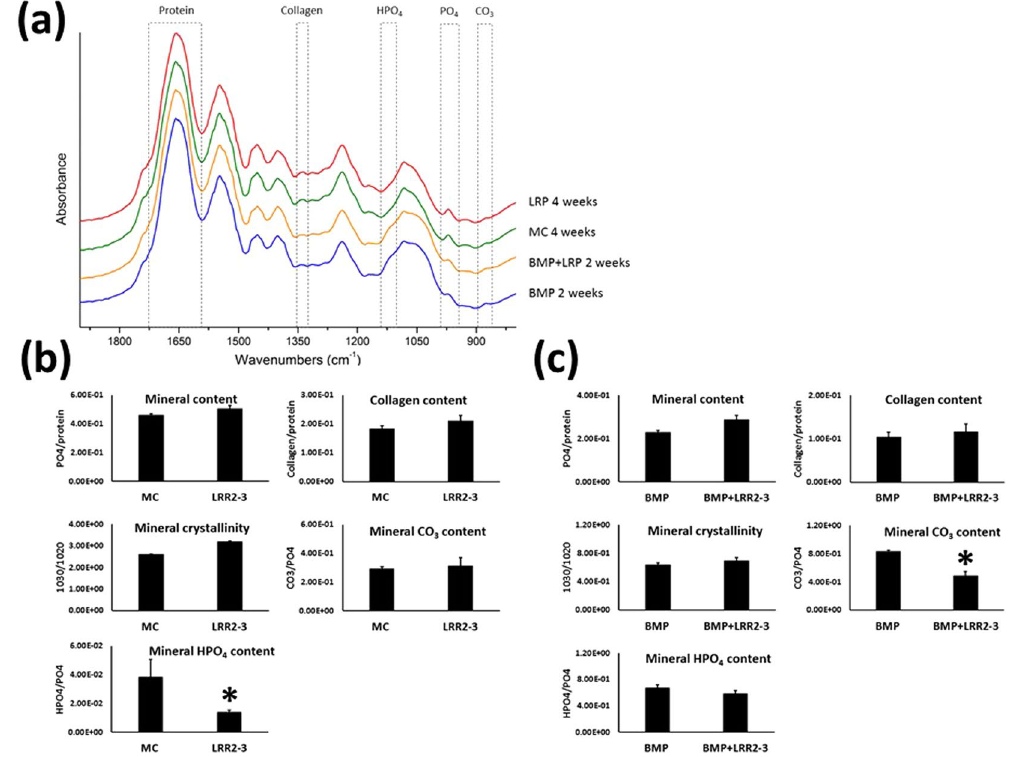
Figure 6. Fourier transform infrared (FTIR) spectroscopy analysis. ( a ) FTIR spectra of the cell culture samples, highlighting the regions of interest: amide I absorbance band for protein, collagen absorbance, the ν 1 PO 4 absorbance band reflecting mineral, the CO 3 absorbance band reflecting carbonate incorporated into the mineral, and the HPO 4 band reflecting acid phosphate incorporated into mineral. Second derivative spectra were used to narrow the broad absorbance peaks, and the peak intensities reported are proportional to the amount of the protein and mineral components present in the cultures. The mineral crystallinity was also investigated based on the ratio of second derivative peaks in the ν 3 PO 4 band at ~1030 and 1020 cm − 1 . ( b ) untreated MC cells or LRR2-3 alone (day 28), ( c ) BMP-2 alone or addition of LRR2-3 to BMP-2 (day 14);. Treatment with LRR2-3 was shown to preserve the development and features of the mineral and matrix formed in the cell cultures, but also resulted in lower levels of non-stoichiometric components of the mineral (CO 3 , HPO 4 ). Samples were analyzed in triplicate (n = 3) and are shown as mean ± S.E. * p <